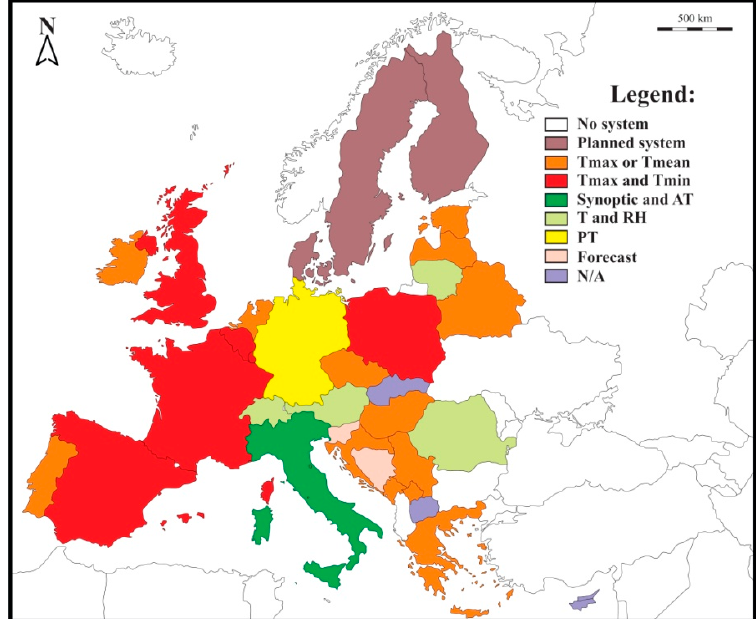
Figure 2. Heat-health warning systems (HHWS) in Europe during 2009. Taxonomy of operational HHWS in Europe—Tmax: maximum temperature; Tmean: mean temperature; Tmin: minimum temperature; AT: apparent temperature; T: Air temperature; RH: relative humidity; PT: perceived temperature. N/A: not known (modified after EURO HEAT project and [102]).